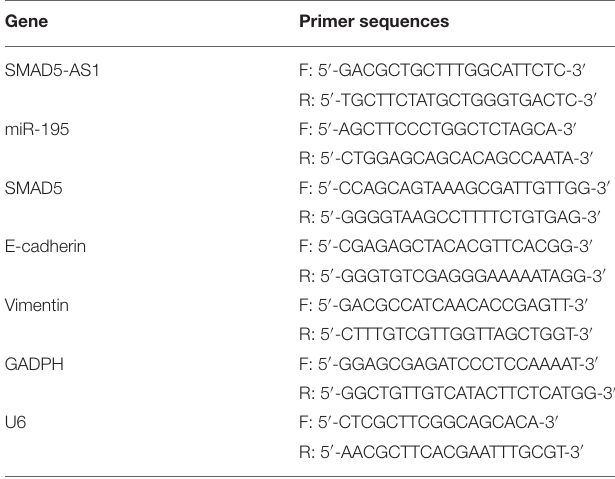
TABLE 1 | Primer sequences for